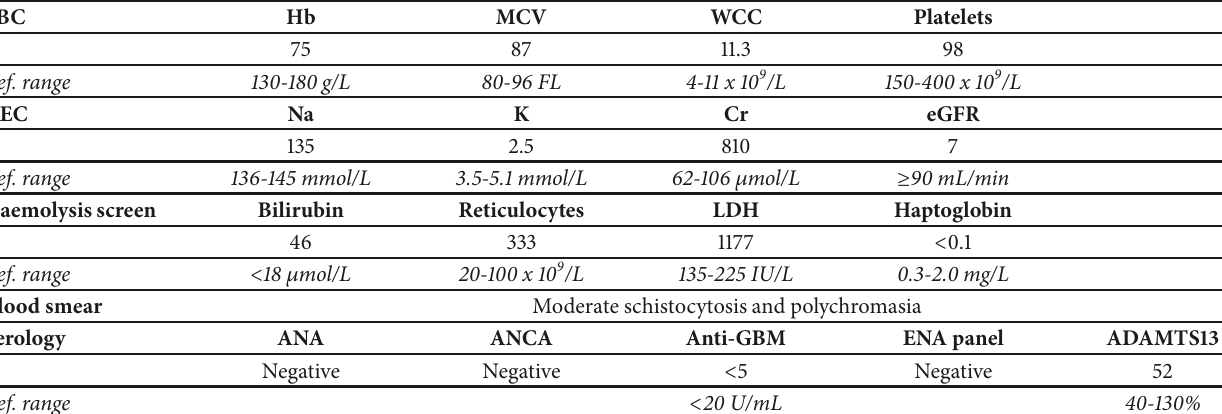
Table 1: Laboratory